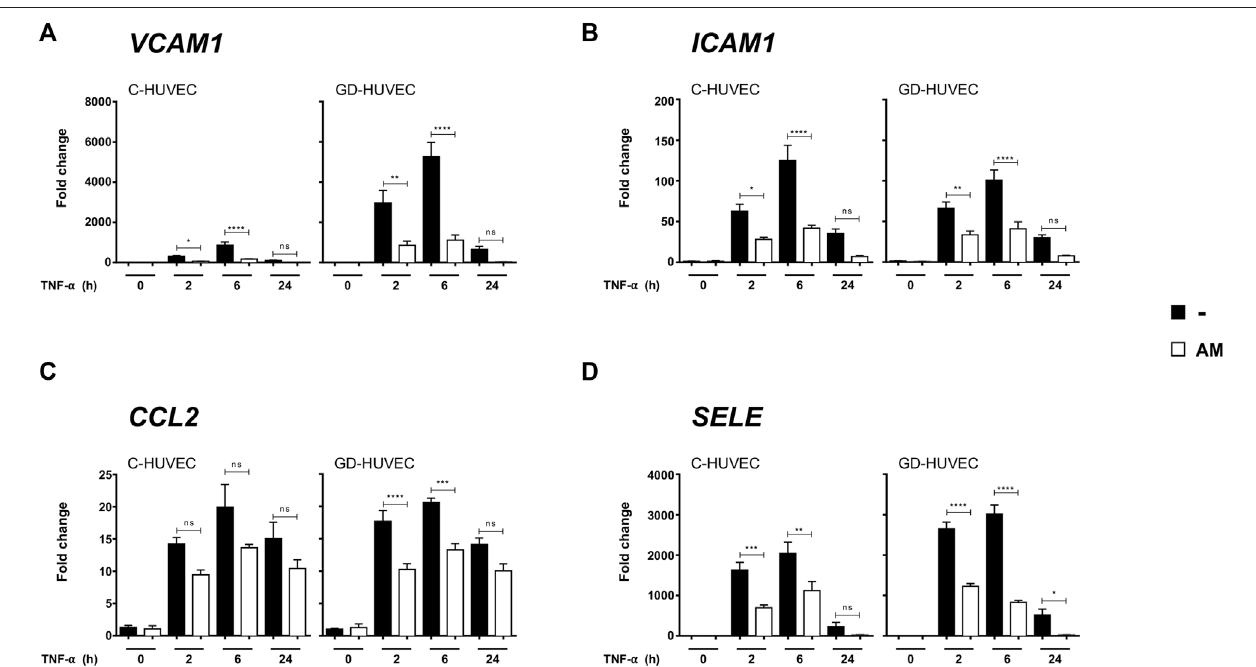
FIGURE1| AMreducestheexpressionofgenesinvolvedinin fl ammation.Geneexpressionanalysisof VCAM-1 (A) , ICAM-1 (B) , CCL2 (C) ,and SELE (D) ,fromC- and GD-HUVECs untreated and after TNF- α stimulation of cells that had been pretreated or not with AM for 24 h. Quantitative data in the histograms (A – D) show the mRNArelativeexpression(targetgeneexpressionnormalizedwithGAPDHexpressionusingthe2- ΔΔ Ctmethod).Eachmeasurementisde fi nedasthemean±SDusing three different strains for C-HUVECs and three different strains for GD-HUVECs ( n = 3). ANOVA and Tukey ’ s multiple comparison test: * p < 0.05, ** p < 0.01, *** p < 0.001 and **** p < 0.0001.